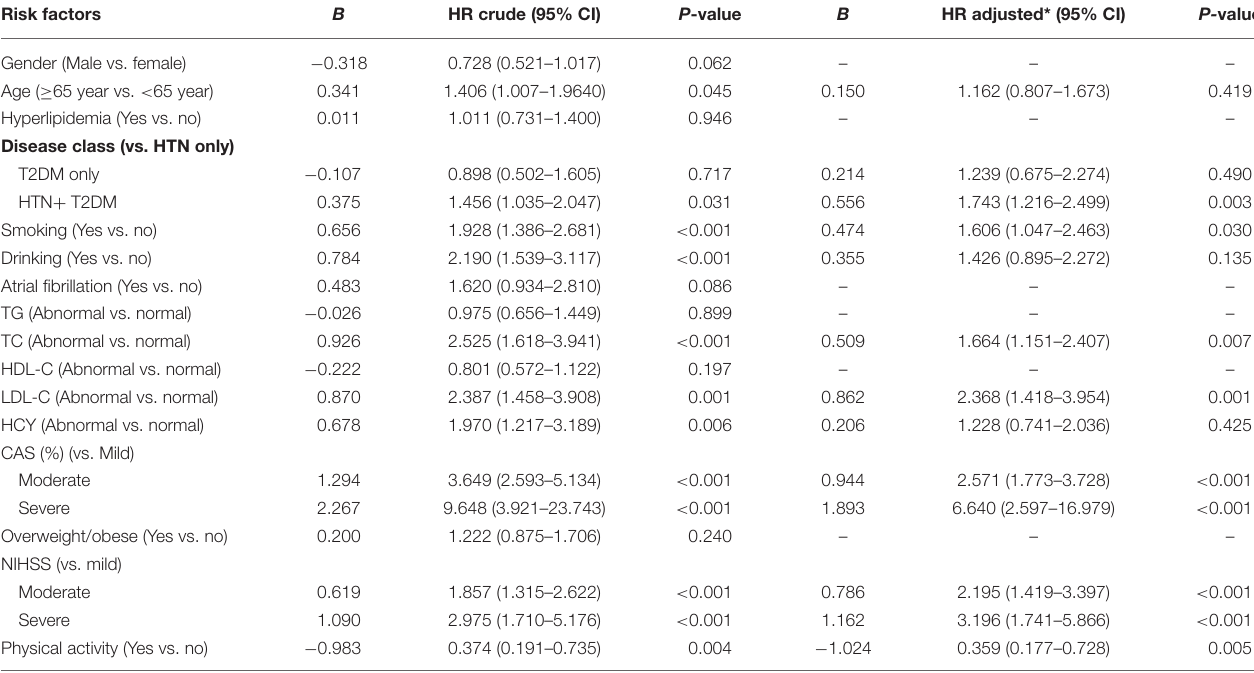
TABLE 5 | The influencing factors of stroke in T2DM and/or HTN patients without stroke history. Risk factors